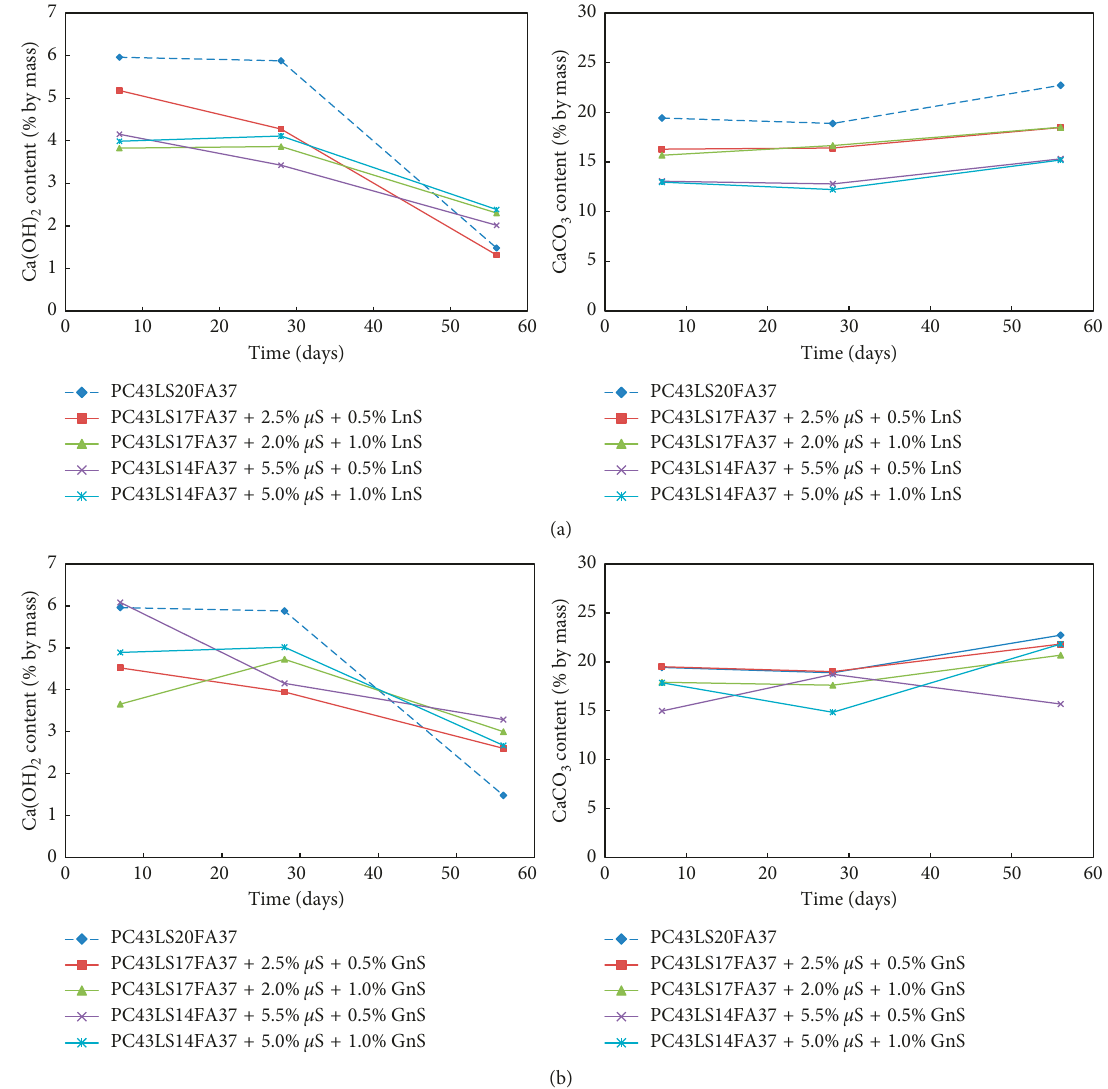
Figure 13: Ca(OH) 2 and CaCO 3 content of μ S and (a) LnS or (b) GnS nanocomposite binders based on